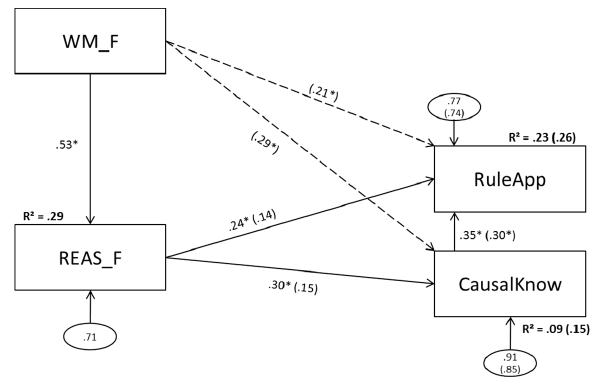
Figure 3. Model 2a(b): Figural working memory components as predictors of figural reasoning; figural reasoning (and figural working memory scores) as predictors of problem solving. WM_F = figural working memory; REAS_F = figural reasoning; CausalKnow = causal knowledge; RuleApp = rule application. Dashed lines and values in parentheses depict changes in model 2b. Statistically significant paths are marked with an asterisk ( α = .05).